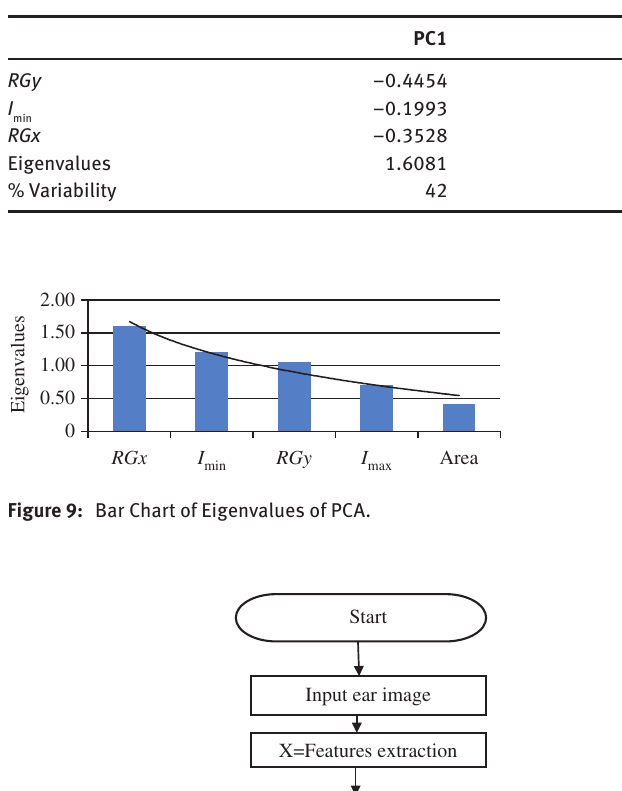
Table 4: Eigenvalue and Eigenvector of Principal Components.